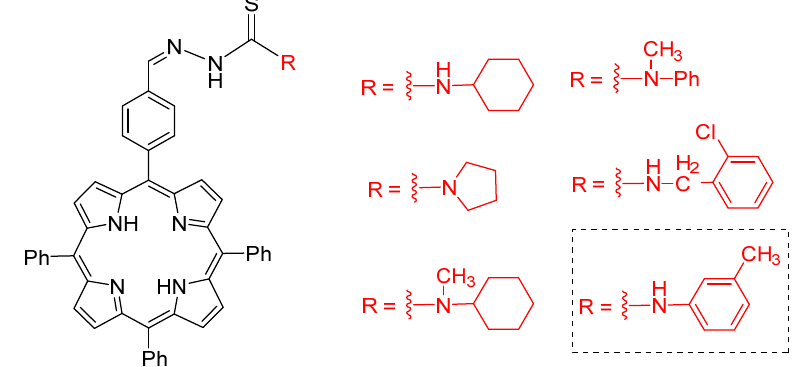
Figure 14. Molecular structures of porphyrin thiosemicarbazides tested against P. falciparum by Bhat et al. [123].